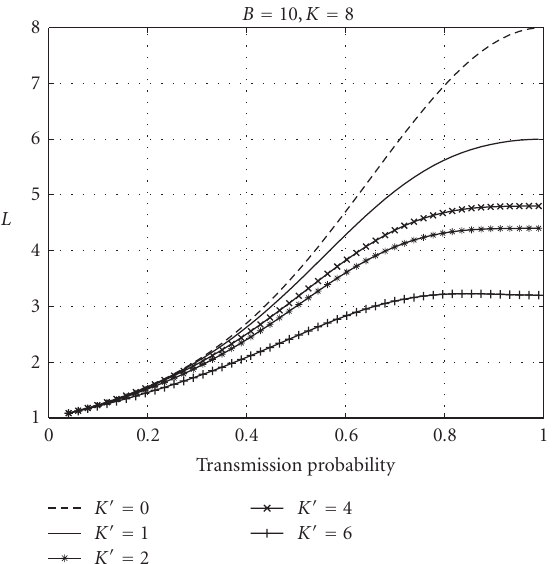
Figure 2: Average number of transmission L for di ff erent K (cid:5) .